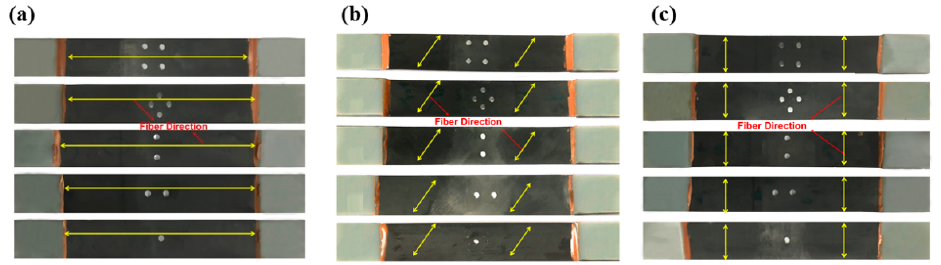
Figure 7. Unidirectional composite samples with ( a ) 0° fiber direction with different hole orientations, ( b ) 90° fiber direction with different hole orientations, ( c ) 45° fiber direction with different hole orientations.